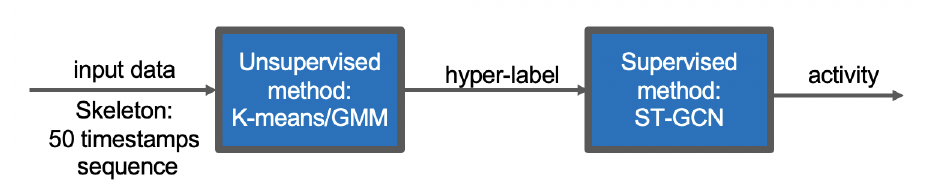
Figure 1. General architecture for the proposed